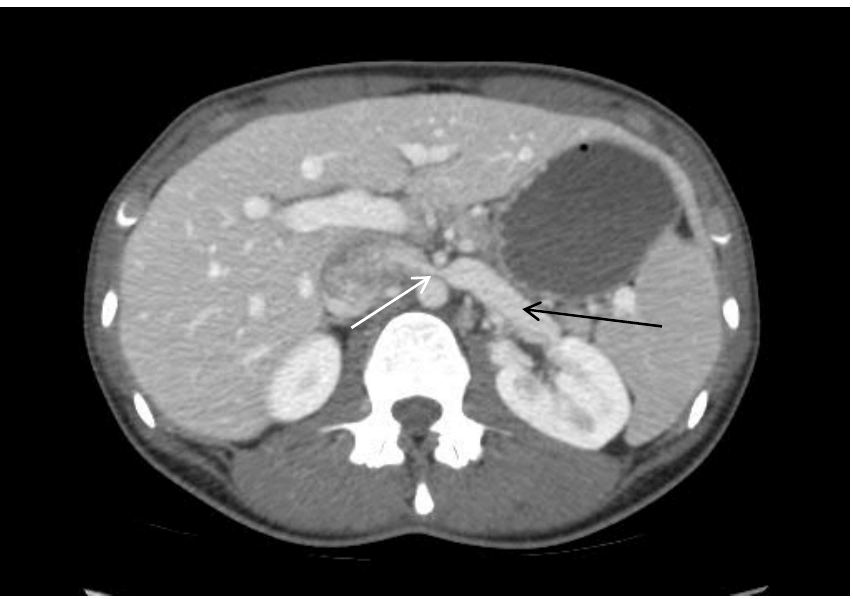
Figure 1. Nutcracker anatomy on computed tomography. White arrow points to compression of the left renal vein (LRV) between the superior mesenteric artery (SMA) and aorta. The black arrow points to LRV dilation.